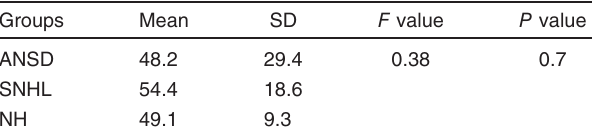
Table 1 Mean, SD, F and P values of age in months in the three study